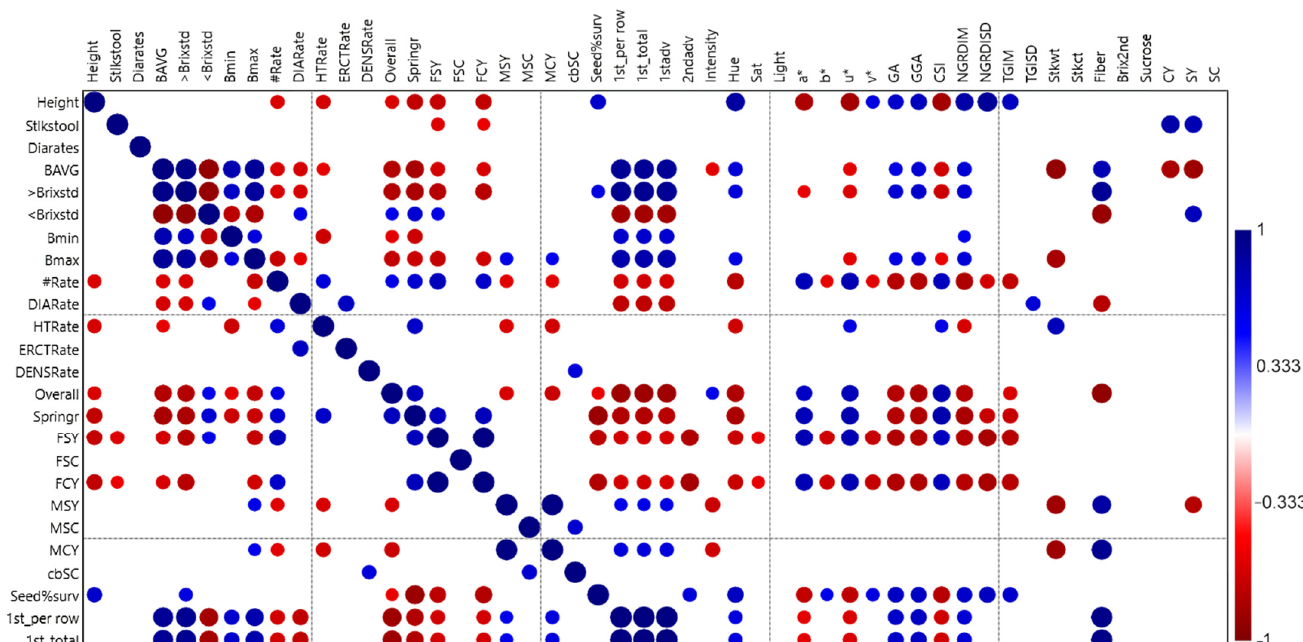
Figure 1. Corrogram of the first 25 selection, yield, and plant cane spectral traits taken on 2 July 2018. Only significant correlations are shown and the larger the circle the larger the correlation with color scale describing the correlation. Height, Stalk height (cm); stlkstool, stalks per stool; Diarates, Stalk diameter rating per stool; BAVG, Brix average from field brixing of 20 seedling stools; >Brixstd, Those selected greater than or equal to Brix standard in seedling trials; <Brixstd, Those not selected based on field Brixing less than field standard in seedling trials; Bmin, Minimum Brix of a family in seedling trials; Bmax, Maximum Brix of a family in seedling trials; #Rate, Seedling stalk number rating: 1 best and 9 worst; DIARate, Seedling diameter Rating: 1 best and 9 worst; HTRate, Seedling height Rating: 1 best and 9 worst; ERCTRate, Seedling erectness rating: 1 best and 9 worst; DENSRate, Seedling density rating: 1 best and 9 worst; Overall, Seedling overall Rating: 1 best and 9 worst; Springr, Seedling spring ratings; FSY, sugar per acre yield of female parent; FSC, sugar per ton yield of female parent; FCY, tons cane per acre yield of female parent; MSY, sugar per acre yield of male parent; MSC, sugar per ton yield of male parent; MCY, tons cane per acre yield of male parent; cbSC, Combined average of sugar per ton yield of both parents; Seed%surv, Seedling survival counts; 1st_per row, First line selections per row; 1st_total, Total first lines selected; 1stadv, Ratio of first lines selected from seedling stage; 2ndadv, Ratio of second lines selected from first line stage; Intensity, CIELab color component; Hue, hue angles in the a*b* plane of the CIELab color space and vary from 0 to 360 ◦ where 0 ◦ is red, 60 ◦ is yellow, 120 ◦ is green, and 180 ◦ is cyan; Sat, Saturation: defines the color purity from white to the corresponding primary color; Light, Lightness: represents the range from black to white with pure black having a value of zero and pure white having a value of ten; a*, The range from green to red; b*, The range from blue to yellow; u*, The scale from blue to red; v*, The scale from blue to green; GA, included the green area (GA), which is the proportion of green pixels in an image; GGA, The greener area (GGA) excludes yellow pixels that correlate with senescent leaves; CSI, the Crop Senescence Index (CSI) = (GA − GGA)/GA × 100; NGRDIM, Mean of the image the Normalized Green–Red Difference Index (Rg − Rr)/(Rg + Rr); NGRDISD, Standard Deviation of NGRDI; TGIM, Mean of the image Triangular Greenness Index − 0.5[( λ r − λ b)(Rr − Rg) − ( λ r − λ g)(Rr − Rb)]; TGISD, Standard Deviation of the TGI; Slkwt, Stalk weight of second line trials; Stkct, Stalk count of second line plots; Fiber, % fiber calculated from 10 stalk sample in second lines; Brix2nd, Second Line Brix; Sucrose, % Juice sucrose content; CY, Cane yield Mg ha − 1 ; SY, Sugar yield Mg ha − 1 ; SC, g kg − 1 Theoretical recoverable